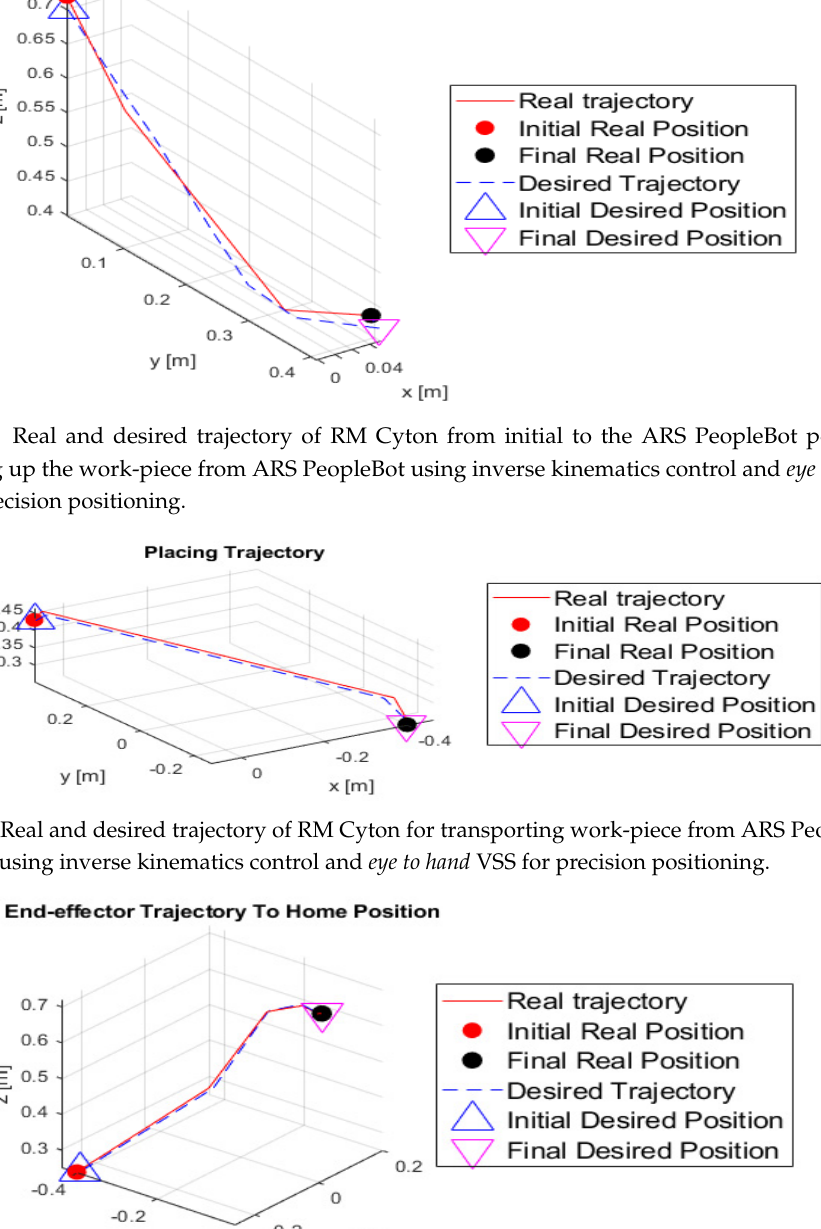
Figure 22. Real and desired trajectory of RM Cyton for transporting work-piece from ARS PeopleBot to P/RML, using inverse kinematics control and eye to hand VSS for precision positioning.